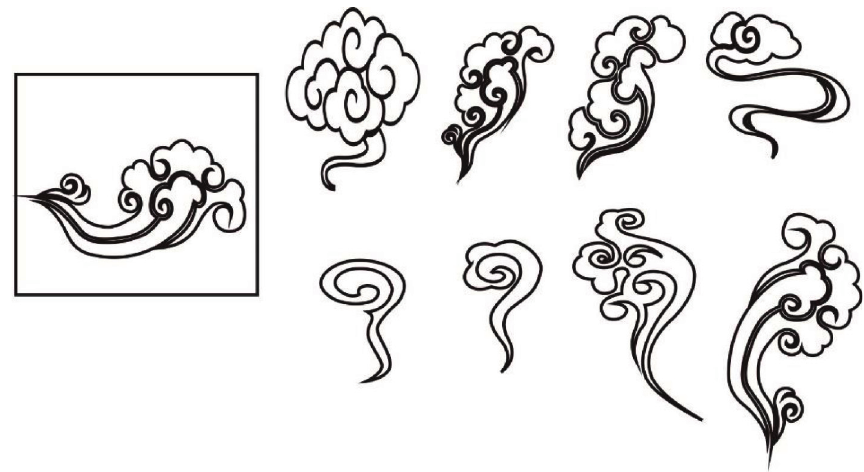
Figure 13: The system makes various computer multimedia art